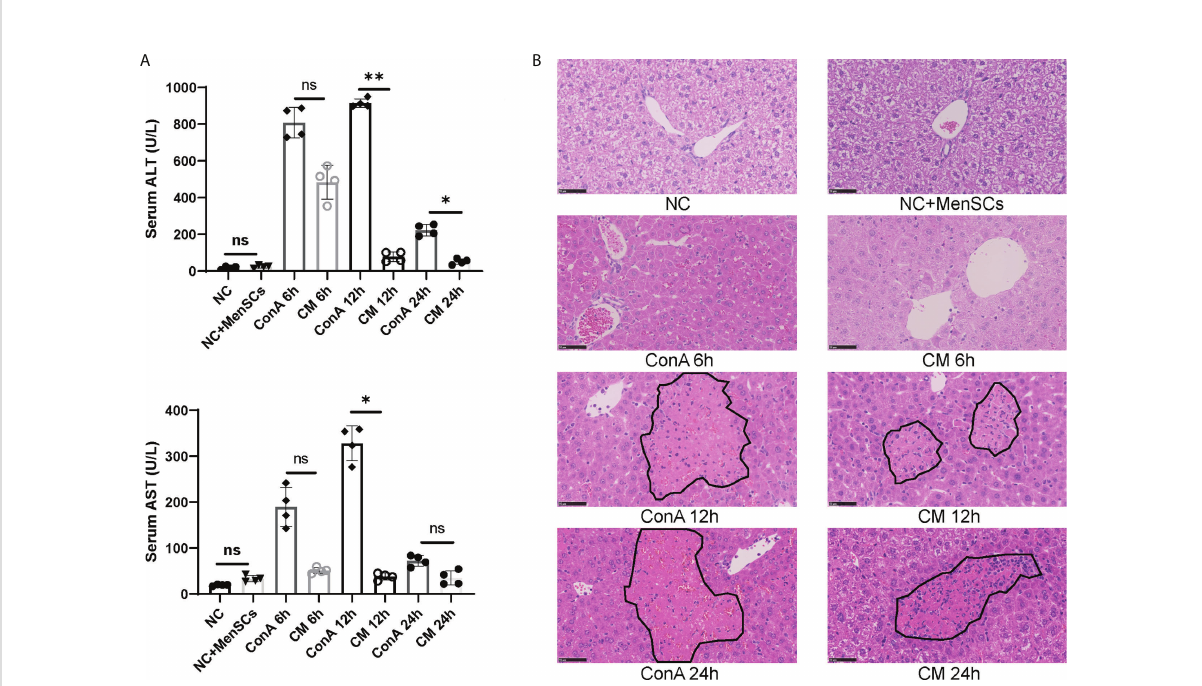
FIGURE 1 MenSCs transplantation ameliorated AIH mouse model. (A) Serum ALT and AST levels of ConA and CM groups at 6, 12, and 24 h and NC and NC+MenSCs groups (n = 4 per group; ns, not statistically signi fi cant, * p < 0.05, ** p < 0.01). (B) Representative images of liver sections stained with H&E (n = 4 per group; black circles represent hepatocellular damage). Data are presented as mean ±